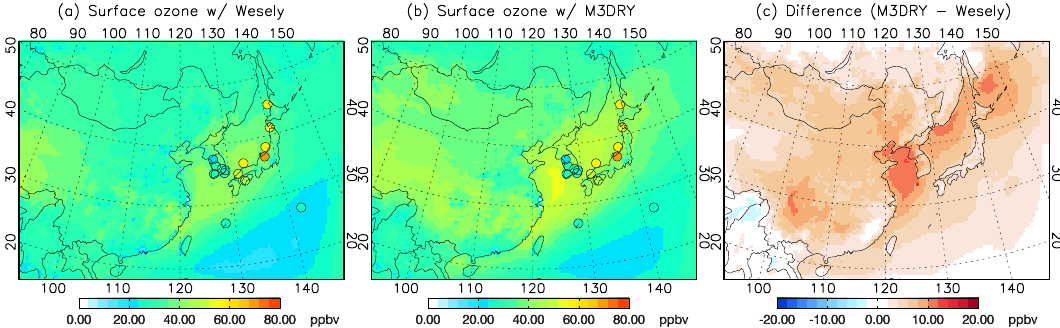
Figure 3. Monthly mean O 3 concentrations in surface air over East Asia for May 2004. The left and middle panels show results from the WRF-Chem model using identical emissions and meteorological input data but different dry deposition schemes, (a) Wesely and (b) M3DRY. Observations from the NIER and EANET sites are denoted with colored closed circles. The O 3 concentration differences between the two simulations are shown in the right panel (c) .